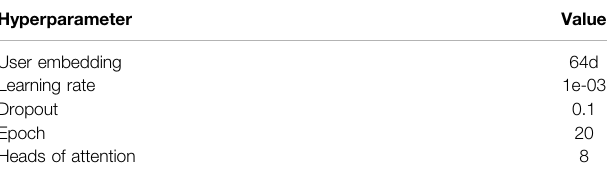
TABLE 2 | The setting of hyperparameters.